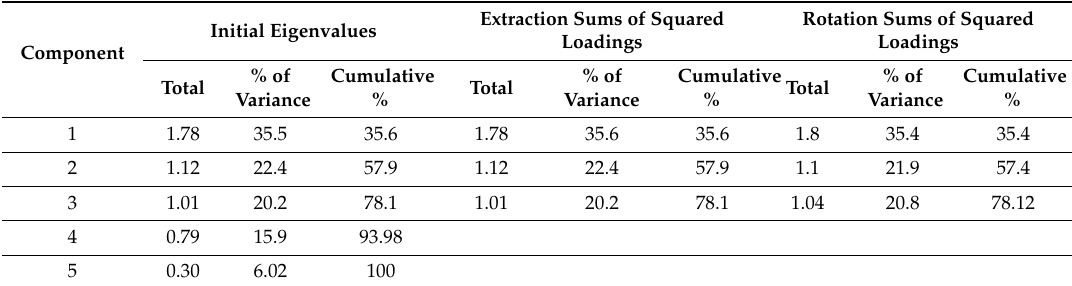
Table 5. Total variance explained, initial eigenvalues, and extracted components.